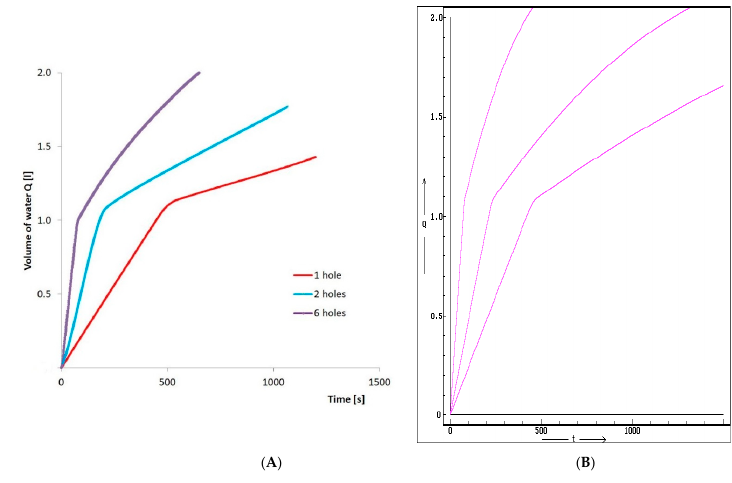
Figure 3. Water flow through the test vessel through a variety of holes. ( A ) Experimental, ( B ) computational.